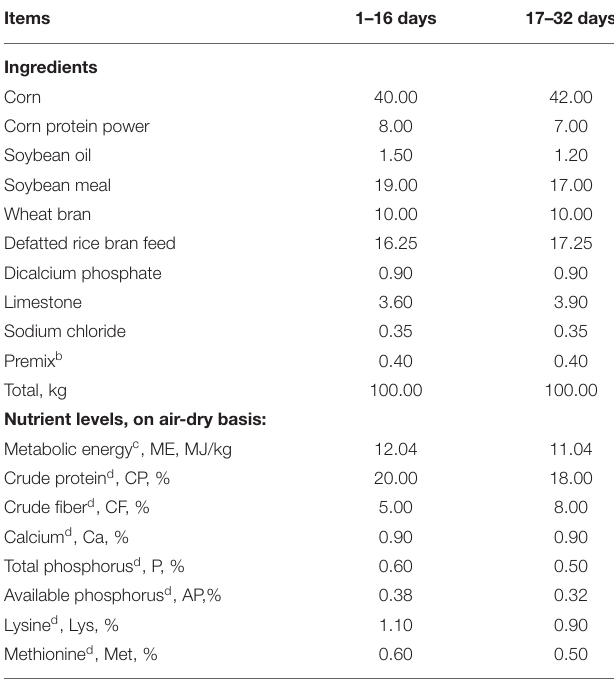
TABLE 1 | Composition (kg/100kg) of the basal experimental diets a for Jiangnan White goslings.